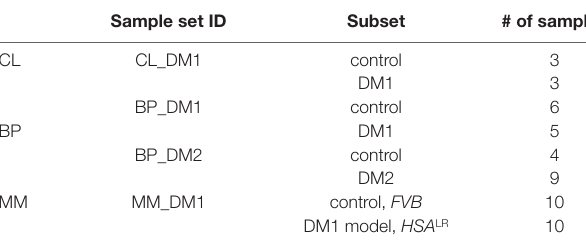
TABLE 1 | Characteristics of sample sets used in the